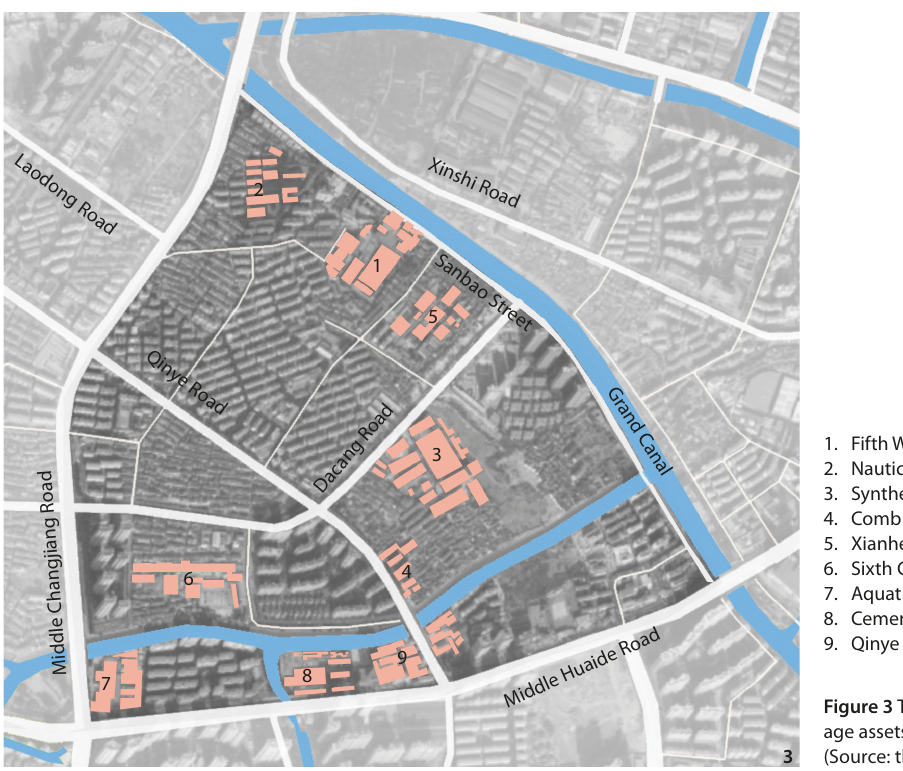
Figure 3 The distribution of industrial herit- age assets in Sanbao Street Historic District (Source: the